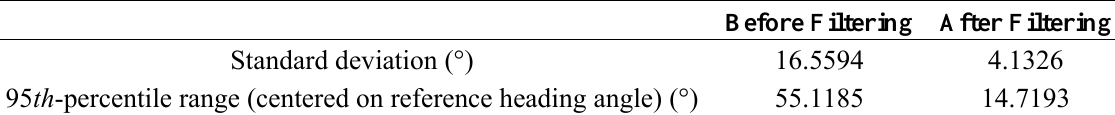
Table 3. Statistical parameters of the heading angle distribution, before and after applying the proposed Kalman filter, along a straight path with a 60° heading angle, in real field